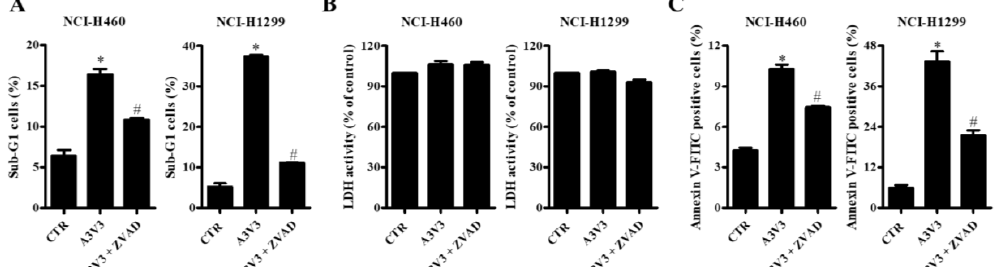
Figure 5. E ff ect of Z-VAD on cell death in ATO / VPA-treated lung cancer cells. Exponentially growing NCI-H460 and NCI-H1299 cells were co-treated with ATO/VPA in the presence or absence of 15 μM NCI-H460 and NCI-H1299 cells were co-treated with ATO / VPA in the presence or absence of 15 µ M Z-VAD for 24 h. Sub-G1 and annexin V-stained cells were measured with BD Accuri C6 flow cytometry. ( A ): Percentages of sub-G1 cells. ( B ): LDH activity changes. ( C ): Percentages of annexin V-FITC positive cells. * p < 0.05 as compared with the control group. # p < 0.05 as compared with cells treated with ATO / VPA. ( n =